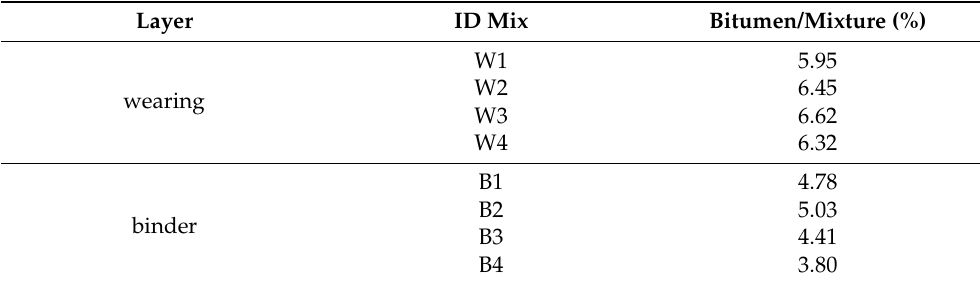
Table 2. Bitumen content.